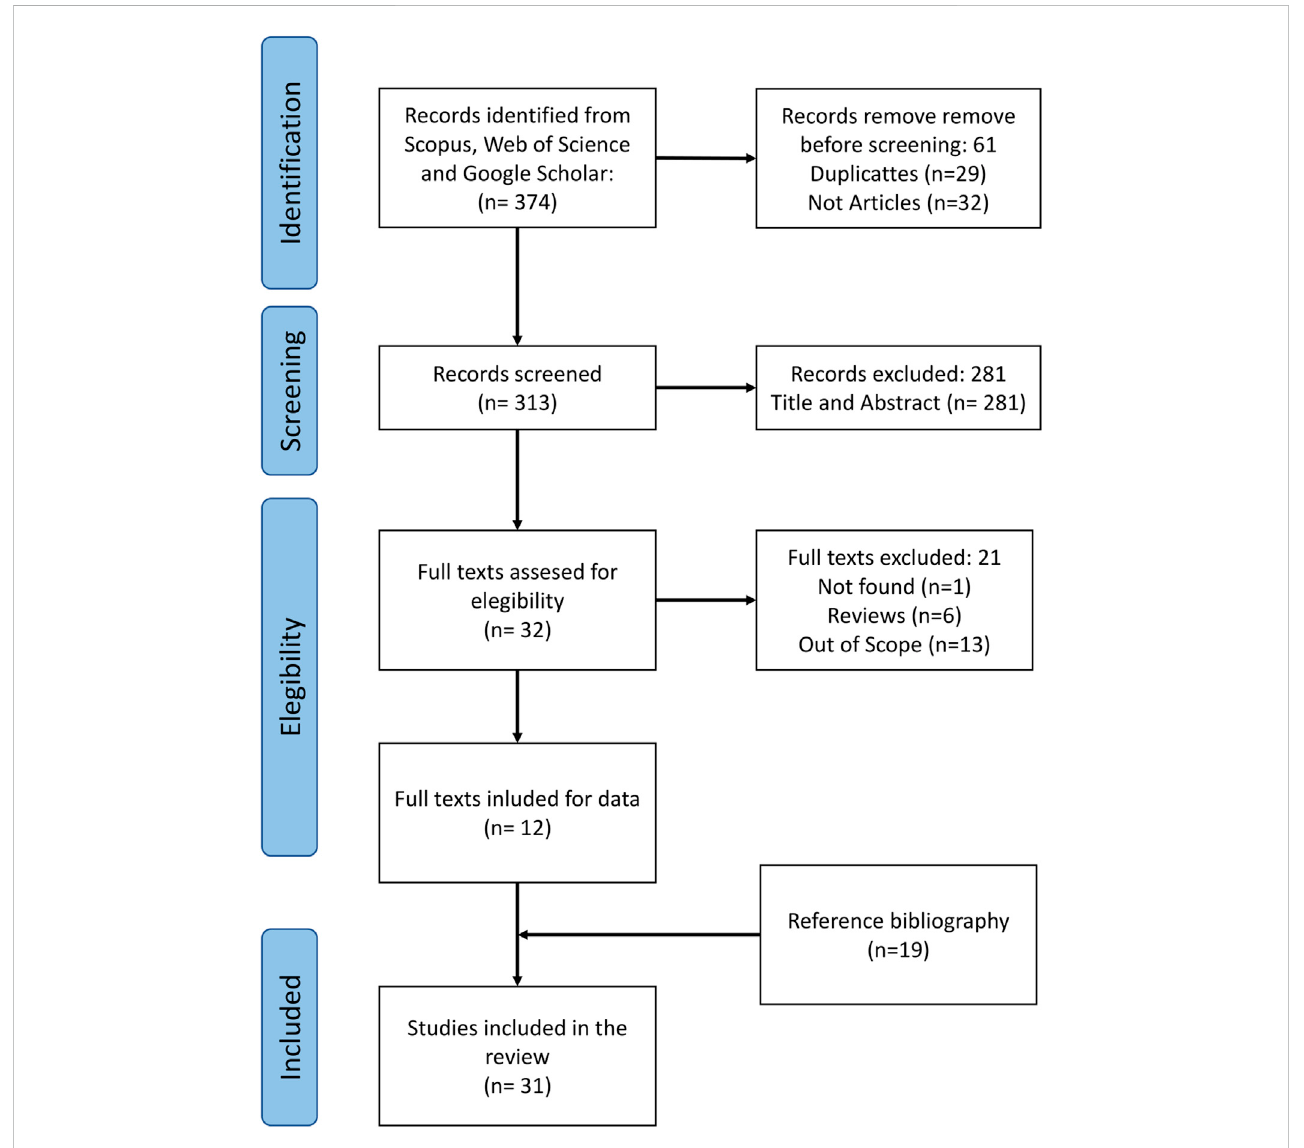
FIGURE 1 Identi fi cation of studies: PRISMA fl ow